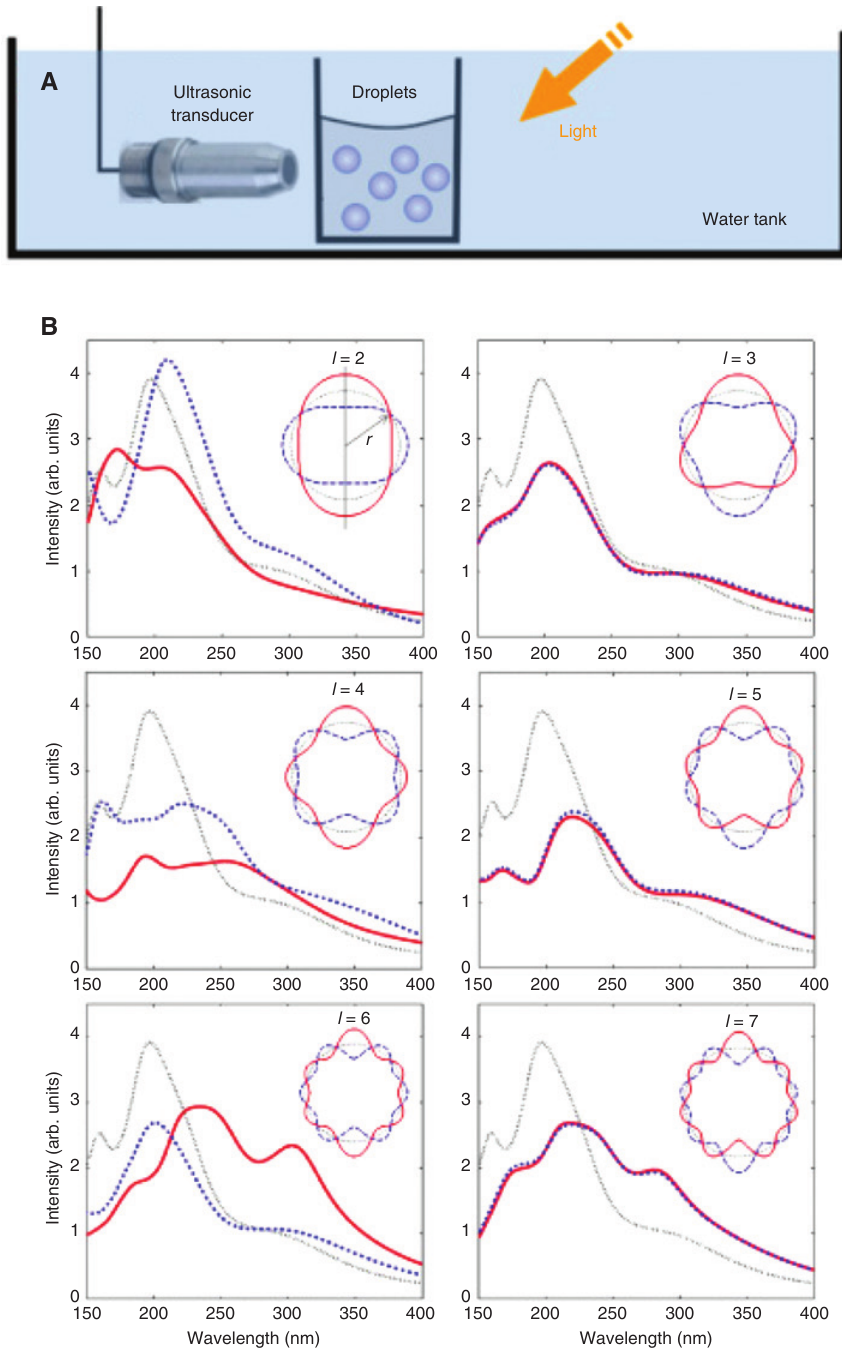
Figure 10: Capillary oscillations of liquid-metal nanoparticles. (A) Schematic of an experimental setup for the excitation of capillary oscillation of a colloidal liquid-metal nanoparticle with ultrasound. (B) Scattered light intensity spectra calculated for static 3D shapes assumed by the nanoparticle at T = 0 (dashed curves), T = 1 (solid curves) and T = 1/2 (dotted curve) shown in Figure 6B. The insets show the cross-sections of these 3D shapes. The same curve styles are used in the insets and the main panels. Reprinted with permission from [140]. Copyright 2017 by the American Physical